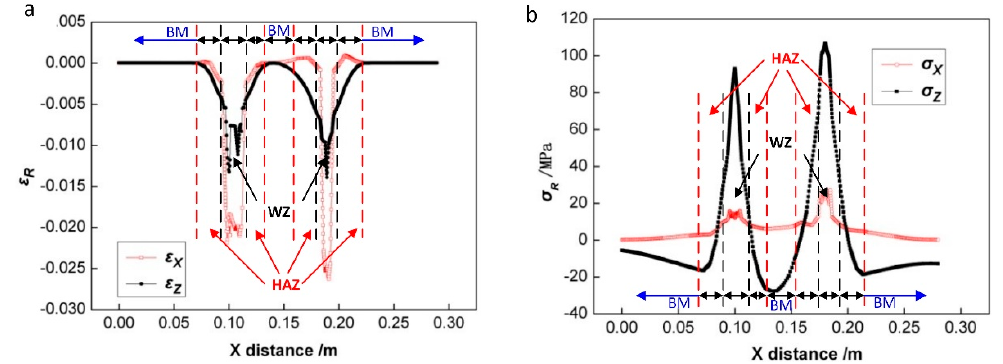
Figure 4. Residual strain distribution of 5A06 aluminum alloy butt welds. ( a ) The longitudinal residual strain. ( b ) The transverse residual strain.